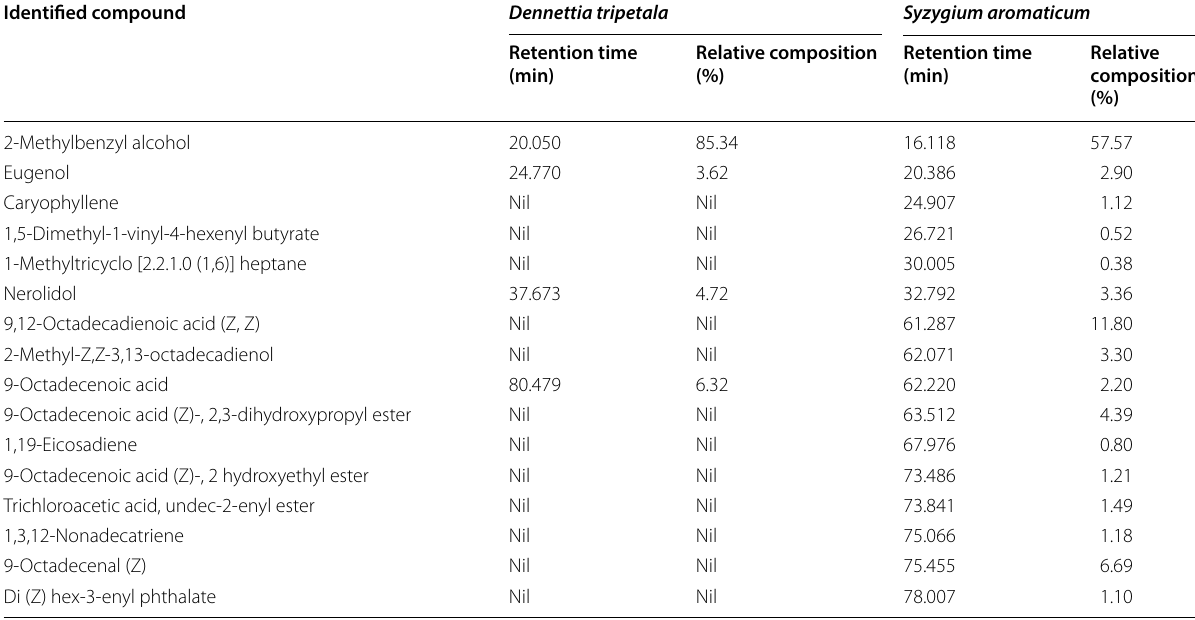
Table 3 The chemical composition of Dennettia tripetala and Syzygium aromaticum Identified